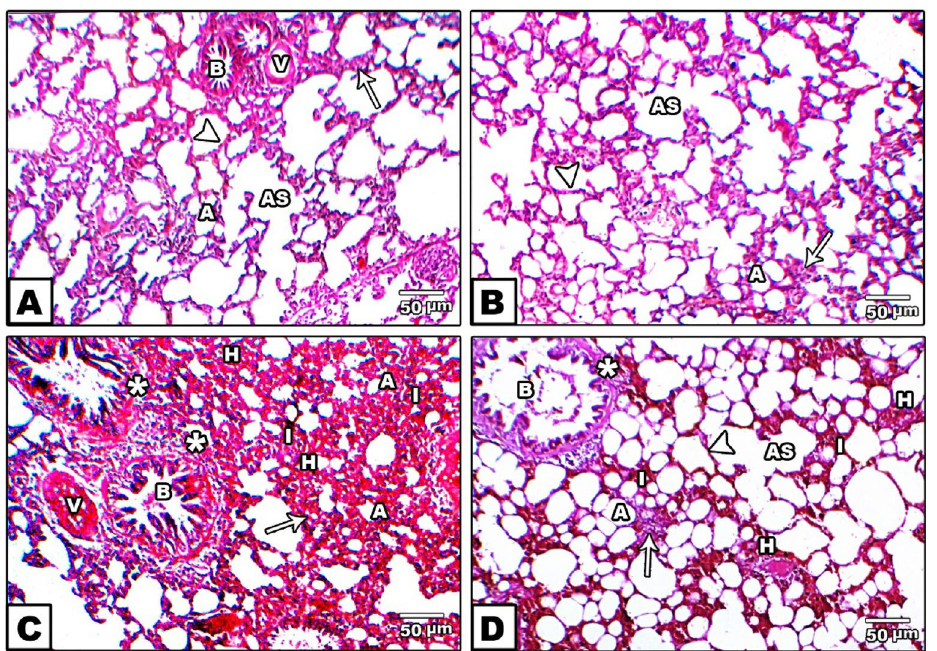
Figure 3. Photomicrographs of H&E stained lungs in the control ( A) and fenugreek ( B ) groups showing normal lung structures of alveolar sacs (AS), alveoli (A), thin (arrowhead) and thick (arrow) interalveolar septa, in addition to normal lung structures of bronchioles (B) and blood vessels (v) appeared in control group. Gasoline-exposed group ( C ) showing bronchioles (B) with thickening (hypertrophy) of the muscular layer of the bronchial wall (star), congested blood vessels (V), marked proliferation of hemorrhage (H) in interstitial tissue (I) that forming thickening in interalveolar septa (arrow) and collapsed alveoli (A). The gasoline + fenugreek seed powder group ( D ) showed a decrease in hyperplasia of bronchioles (star), reduced proliferation of hemorrhage (H) in interstitial tissue (I), appearance of alveolar sacs (AS), and alveoli (A) with thin (arrowhead) and thick (arrow) alveolar septa compared to the gasoline